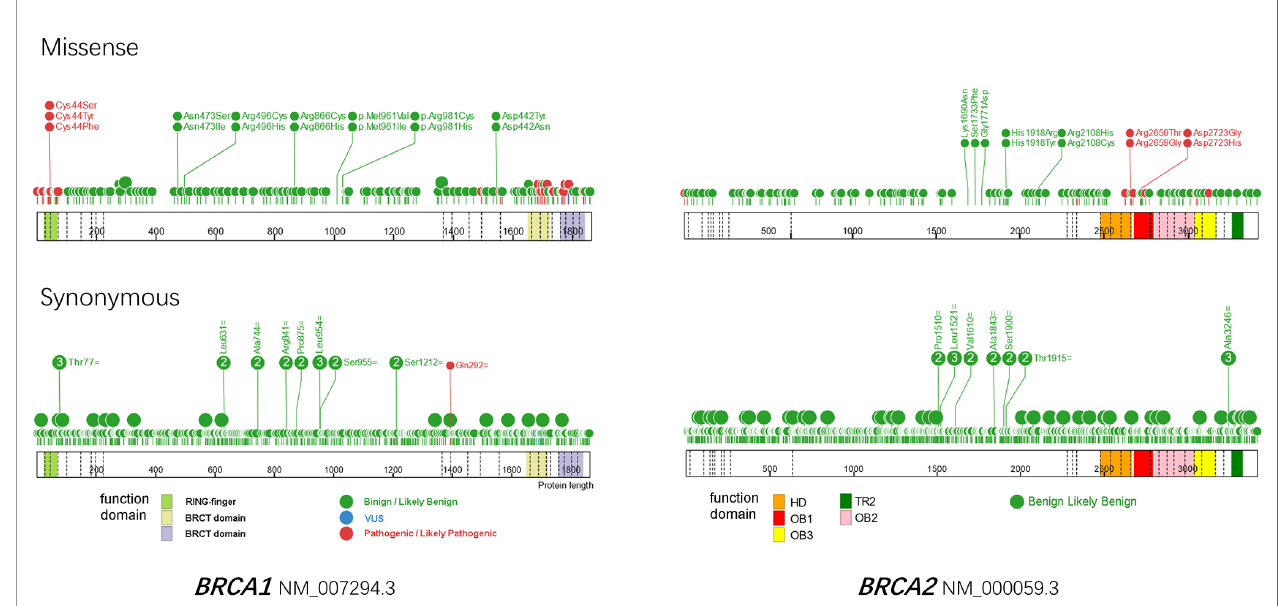
FIGURE 2 | Protein paint of missense (upper) and synonymous variants reviewed by ENIGMA expert panel in BRCA1 (left) and BRCA2 (right). A total of 173 missense and 462 synonymous variants are plotted for BRCA1 , as well as 143 missense and 782 synonymous variants for BRCA2 . The reference transcripts of NM_007294.3 and NM_000059.3 are used for BRCA1 and BRCA2 respectively. Benign and likely benign variants are in green, VUS are in blue, pathogenic and likely pathogenic variants are in red. Dashed lines indicate exons. HD, helical domain; OB, oligosaccharide-binding folds; TR2, C-terminal RAD51 interaction